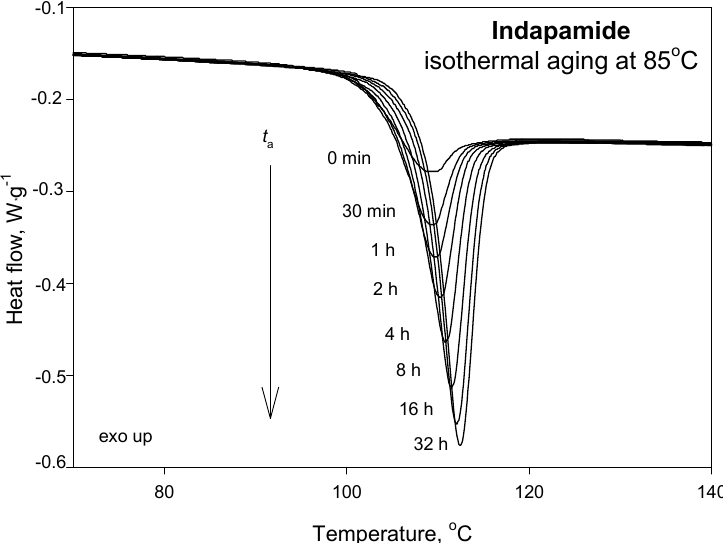
Figure 4. Heat-flow plot as a function of the temperature obtained from DSC measurements during heating indapamide with a constant heating rate of 10 °C·min − 1 after isothermal ageing at 85 °C for various ageing times, up to 32 h.